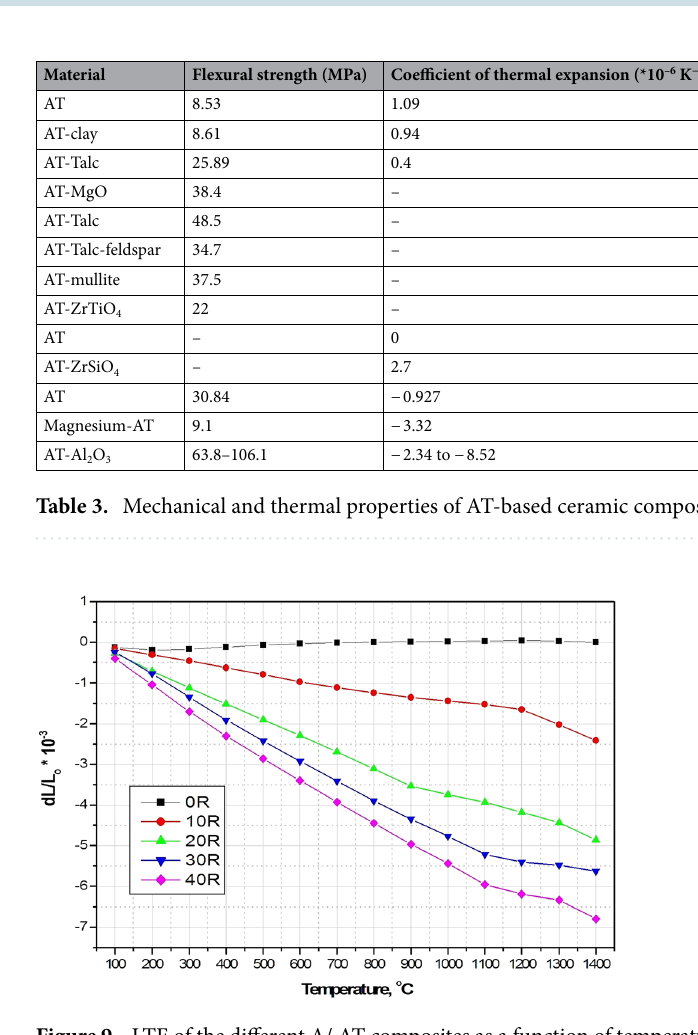
Figure 9. LTE of the different A/ AT composites as a function of temperature.